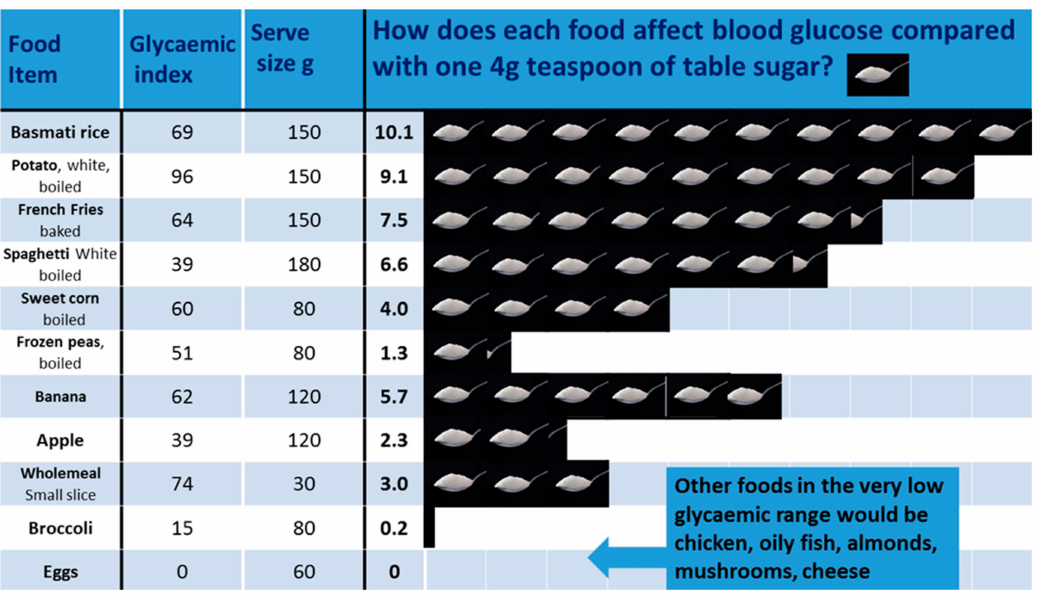
Figure 2. Patient friendly infographic to represent the glycaemic load of various